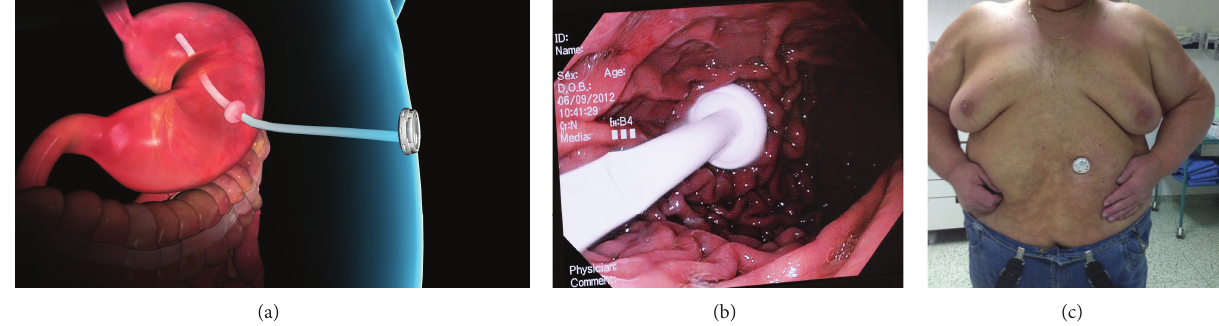
Figure 4: The AspireAssist device used to stimulate weight loss. (a) Animation of the device when placed in situ. (b) Endoscopic view of the AspireAssist device. Note the long, wide-bore intragastric tube to aid in efficient aspiration. (c) The external portion of the device on the skin showing minimal elevation on the